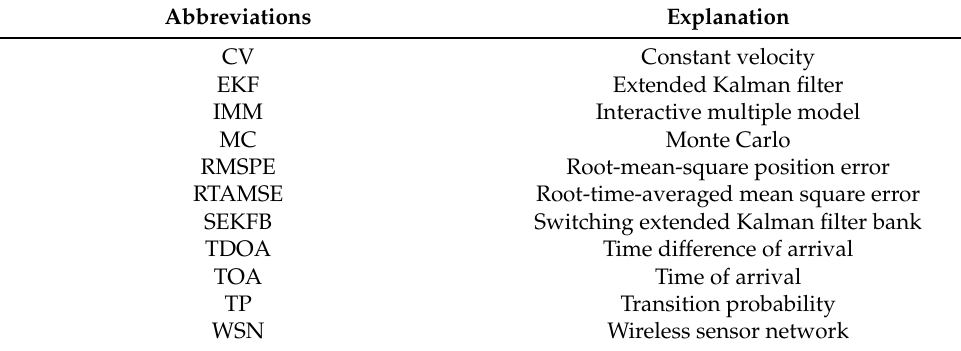
Table 1. List of abbreviations.